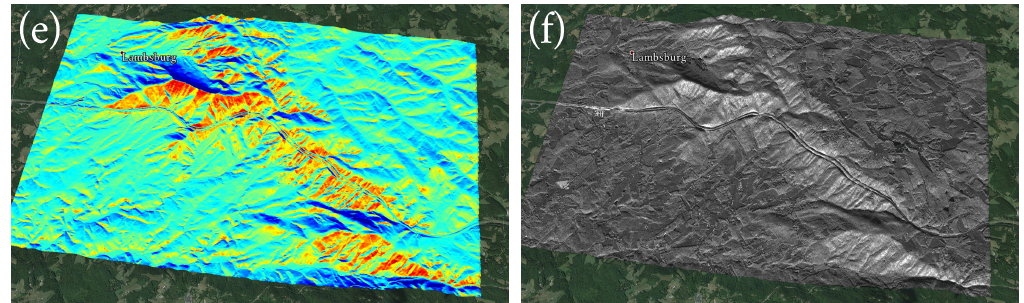
Figure 9. Left column: the simulated geometric distortion map of COSMO with three different incidence angles. Red color shows areas with severe geometric distortion and blue color means less geometric distortion. Right column: The corresponding intensity map. ( a , b ): simulated geometric distortion severity map and reflectivity map for COSMO ascending track with 32 ◦ incidence angle; ( c , d ): COSMO descending track with 34 ◦ incidence angle; ( e , f ): descending track with 56 ◦ incidence angle.